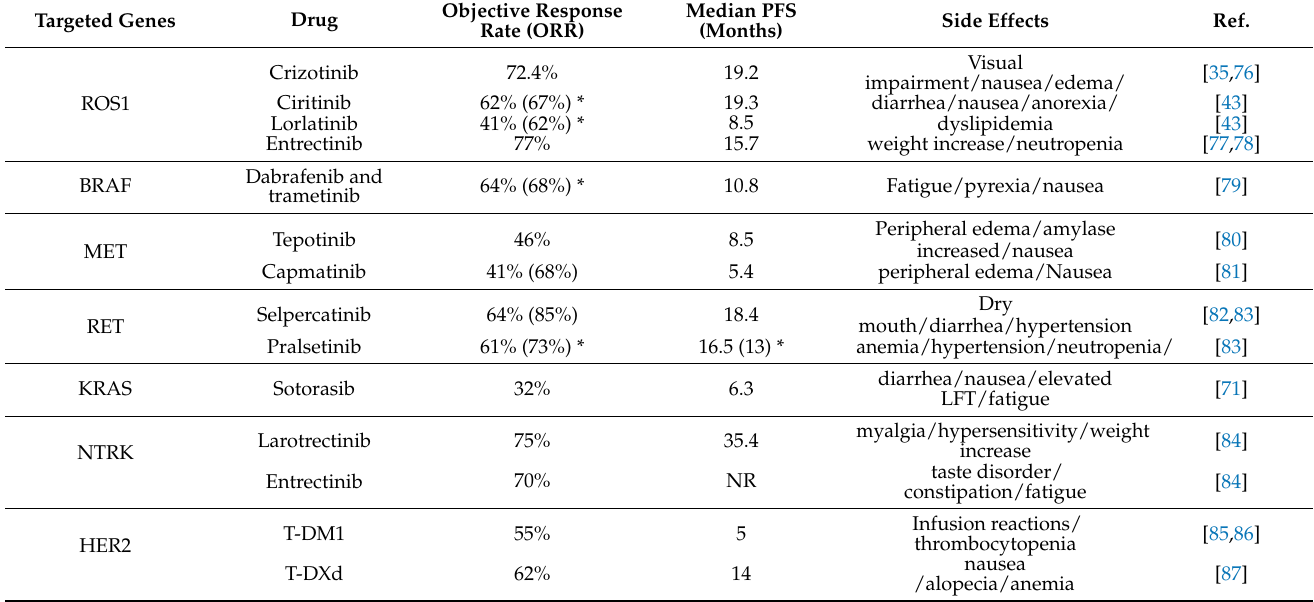
Table 3. Summary of other FDA-approved drugs targeting